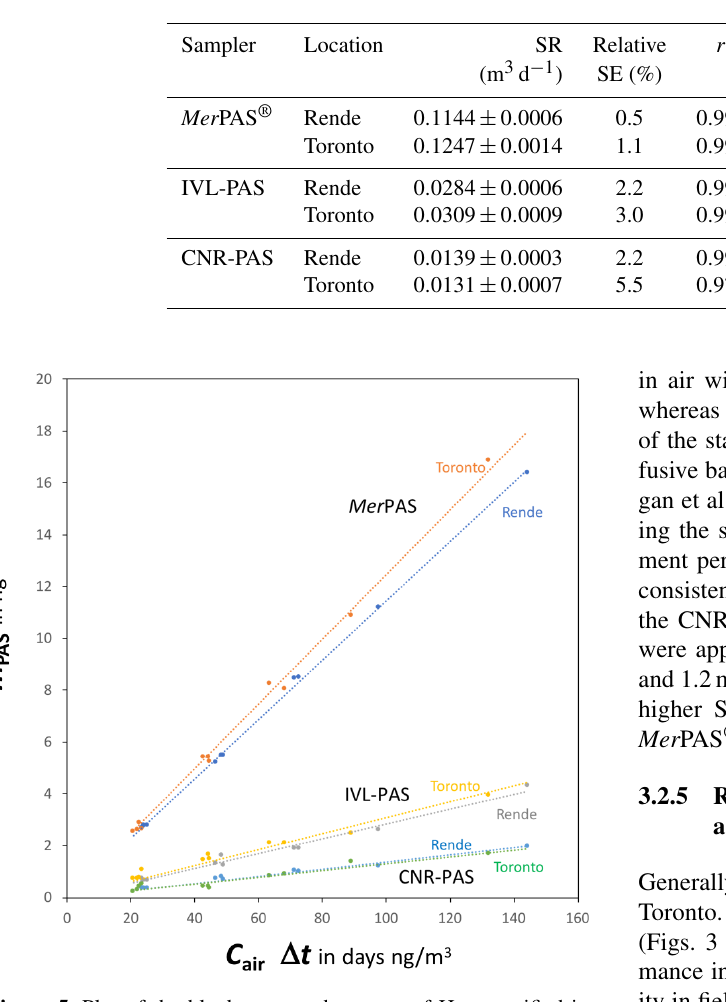
Figure 5. Plot of the blank-corrected amount of Hg quantified in three types a passive air sampler deployed in Rende or Toronto against the product of the deployment time of a sampler (cid:49)t and the average air concentration during the deployment of that sam- pler C air , as determined independently by a Tekran active sampling